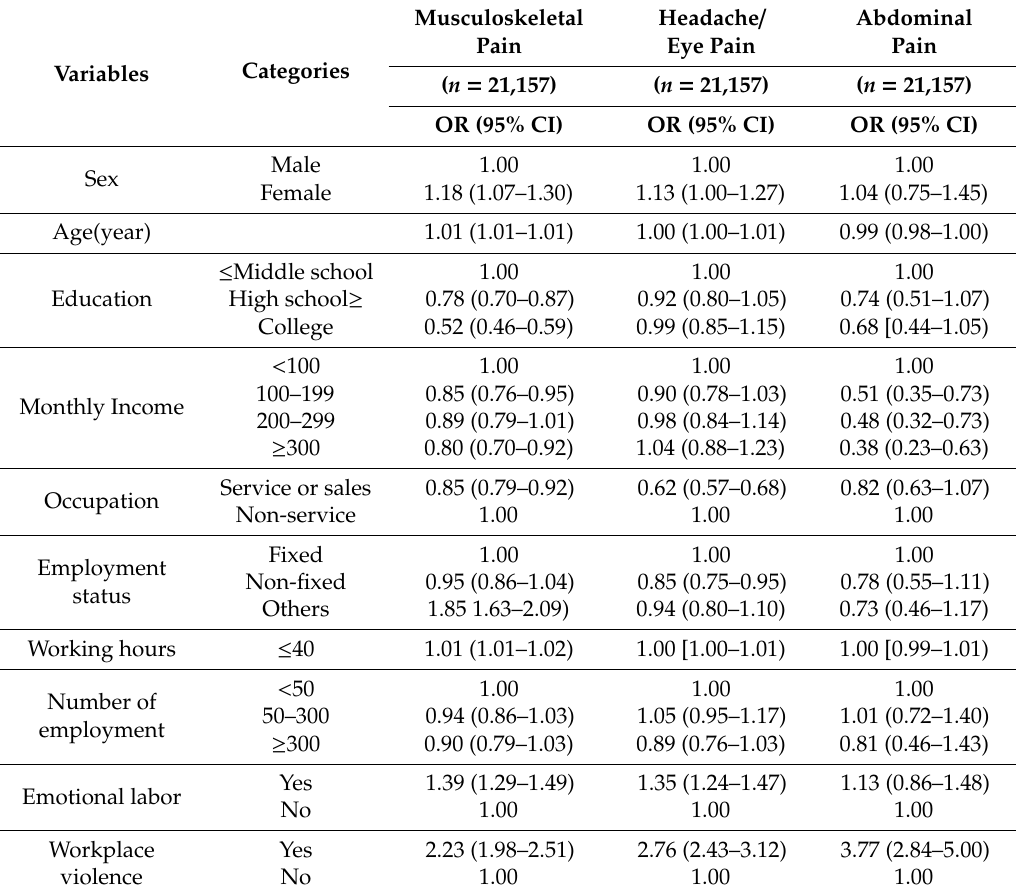
Table 4. Impact of Emotional Labor and Workplace Violence in Physical Health